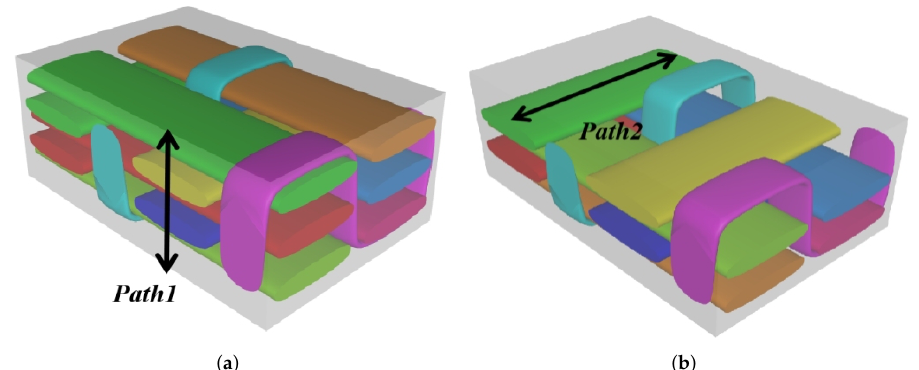
Figure 8. Path selection in local field recovery analysis. ( a ) Path 1 along the Z direction; and ( b ) Path 2 along the Y direction.